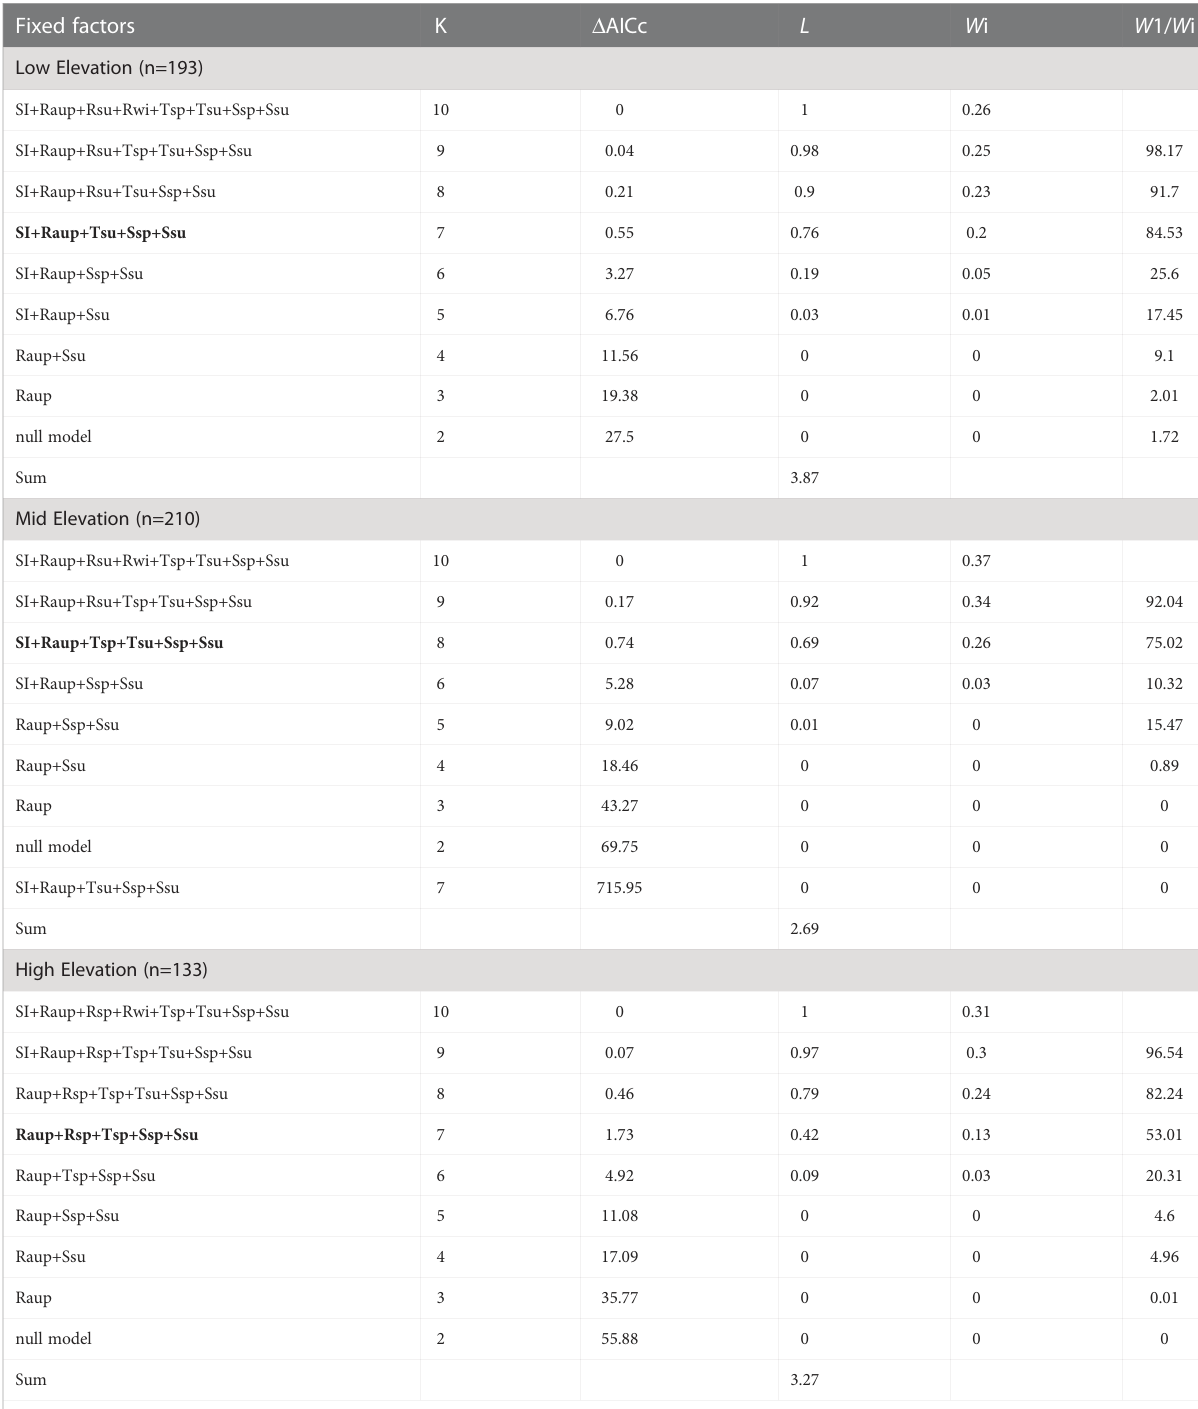
TABLE 1 Model selection criteria for Abies pinsapo -dominated forests NDVI along three elevation belts: low elevation (880-1150 m a.s.l.), mid elevation (1150-1350 m a.s.l.) and high elevation (1350-1550 m a.s.l.). Fixed